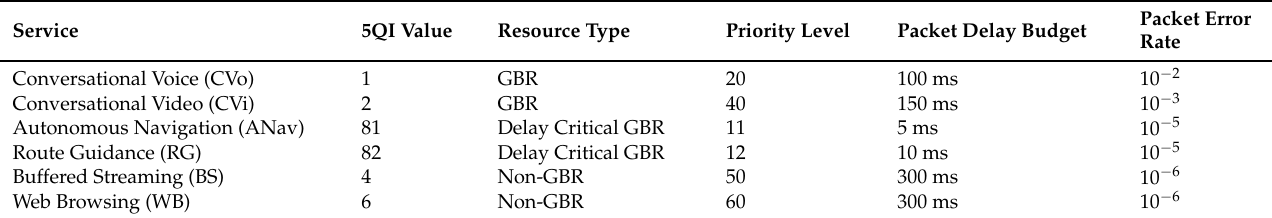
Table 3. The 5QI value and the corresponding constraints for each service.